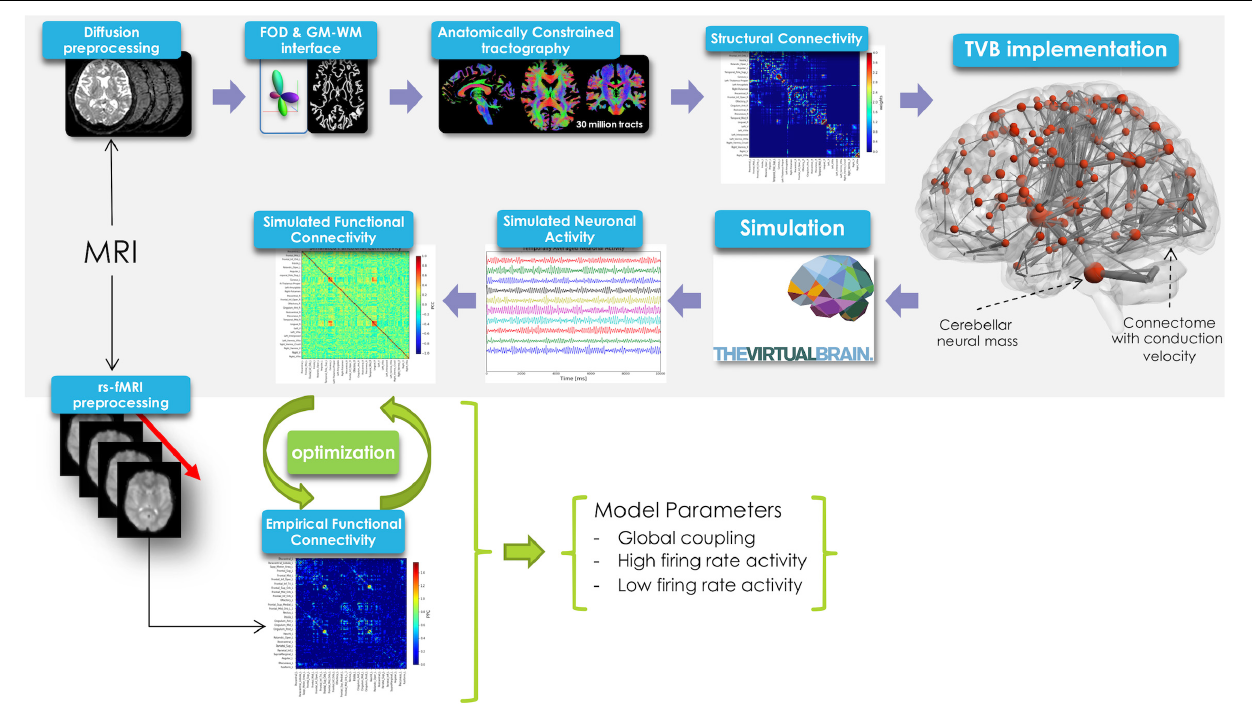
FIGURE 1 | Schematic representation of the experimental and modeling workflow. From top left, clockwise: diffusion preprocessing, fiber orientation distribution calculation, whole-brain tractography, creation of structural connectome and its integration in TVB, spatio-temporal neural mass activity simulation, simulated functional connectivity matrix definition. Simulated FC was optimized using a model inversion approach with the empirical FC as target.